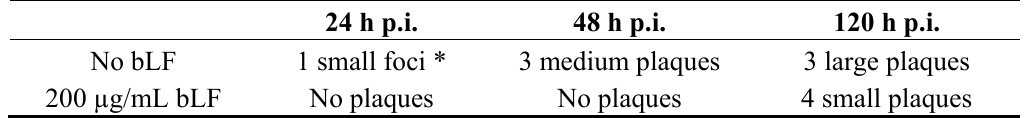
Table 1. Lactoferrin inhibition of SINVTaV-GFP-TC plaque-formation at M.O.I. of